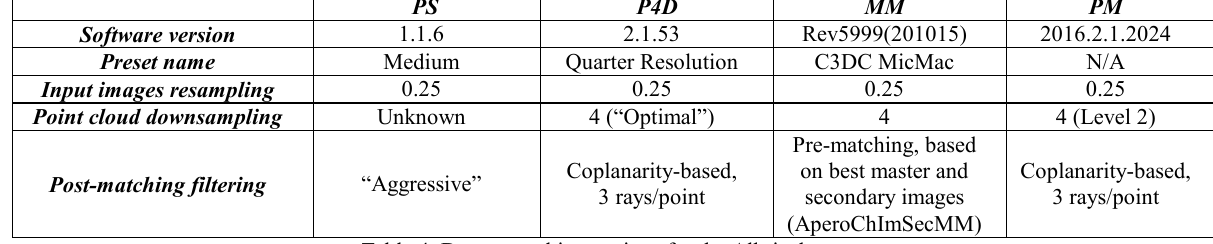
Table 4. Dense matching settings for the Albris data set.